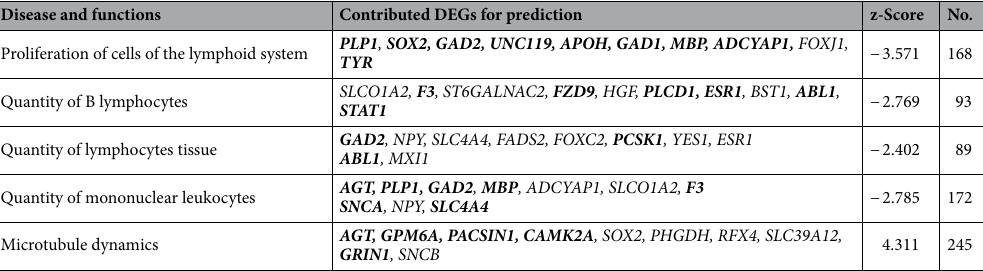
Disease and functions Contributed DEGs for prediction z-Score